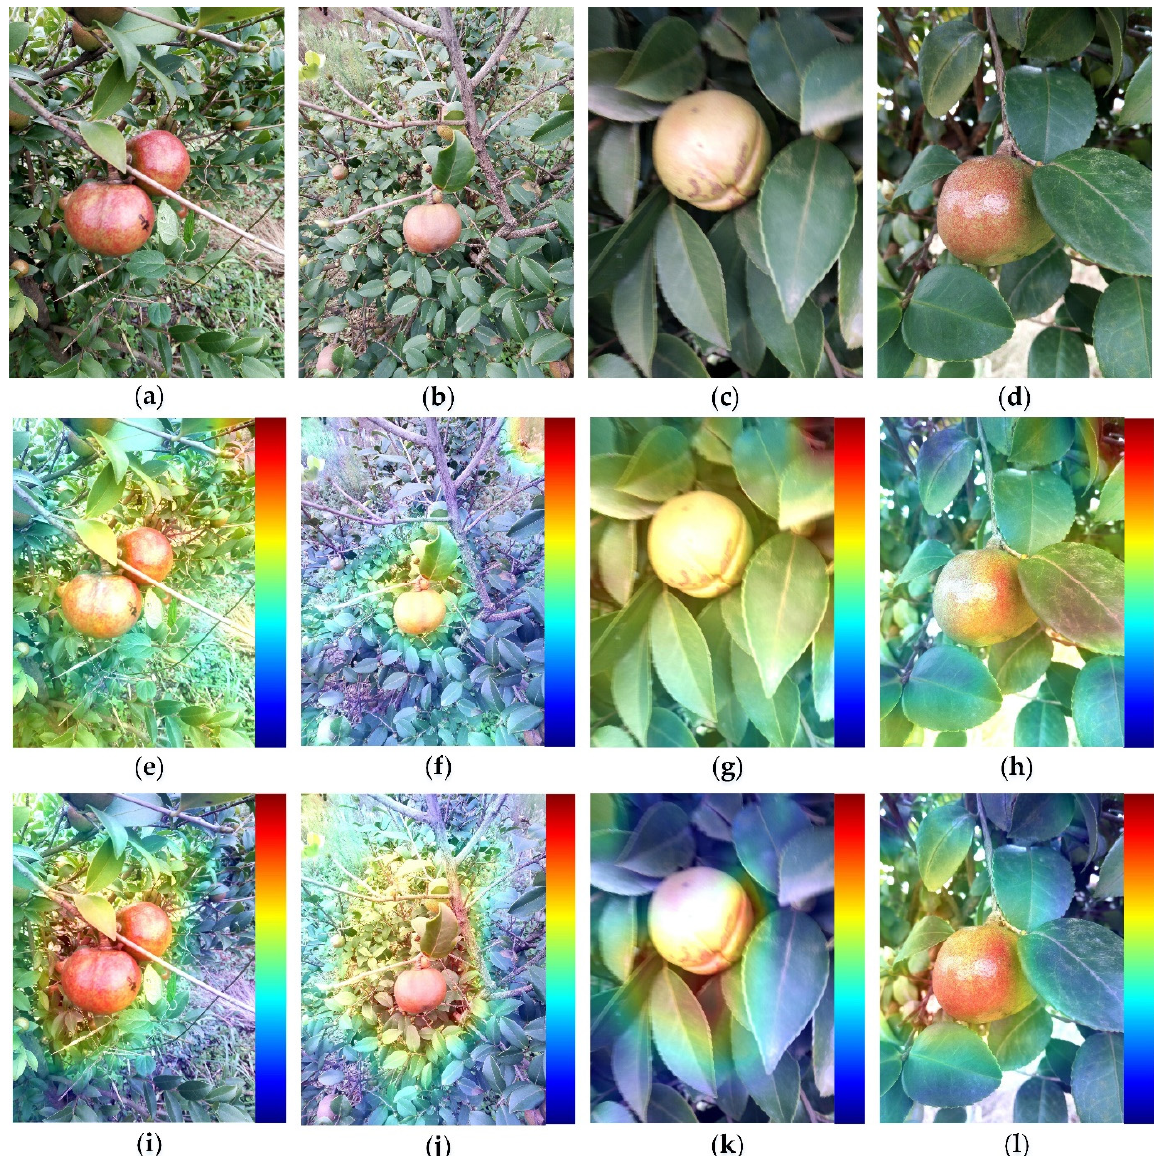
Figure 7. Attention heat maps of EfficientNet-B4 and EfficientNet-B4-CBAM. ( a ) Original image of Xianglin 210; ( b ) Original image of Huashuo; ( c ) Original image of Huajin; ( d ) Original image of Hauxin; ( e ) EfficientNet-B4 identification heat map of Xianglin 210; ( f ) EfficientNet-B4 identification heat map of Huashuo; ( g ) EfficientNet-B4 identification heat map of Huaxin; ( h ) EfficientNet-B4 identification heat map of Huajin; ( i ) EfficientNet-B4-CBAM identification heat map of Xianglin 210; ( j ) EfficientNet-B4-CBAM identification heat map of Huashuo; ( k ) EfficientNet-B4-CBAM identification heat map of Huaxin; ( l ) EfficientNet-B4-CBAM identification heat map of Huajin.